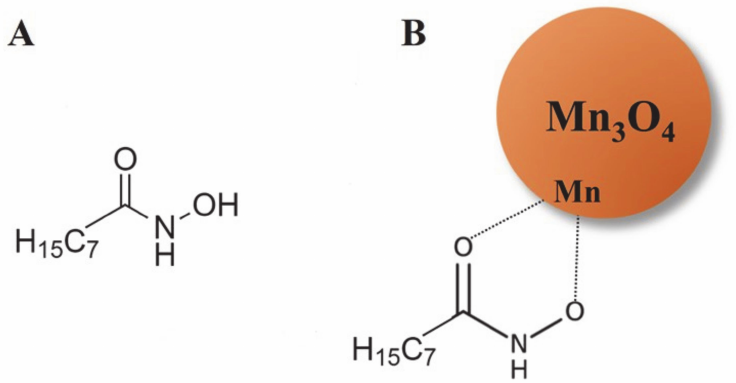
Figure 4. ( A ) The chemical structure of OHA, ( B ) OHA adsorption on Mn 3 O 4 particles, involving complexation of surface Mn atoms.